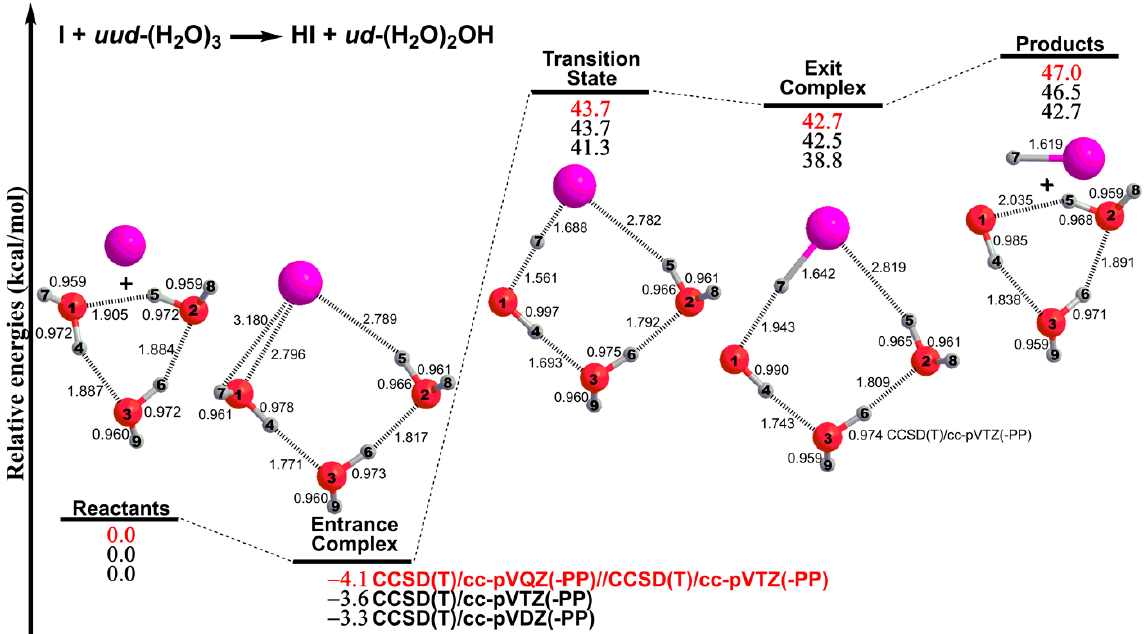
Figure 1. Stationary points on the lowest-energy potential energy profile of the I + (H 2 O) 3 reaction. The distances and relative energies are given in angstroms and kcal mol − 1 , respectively.